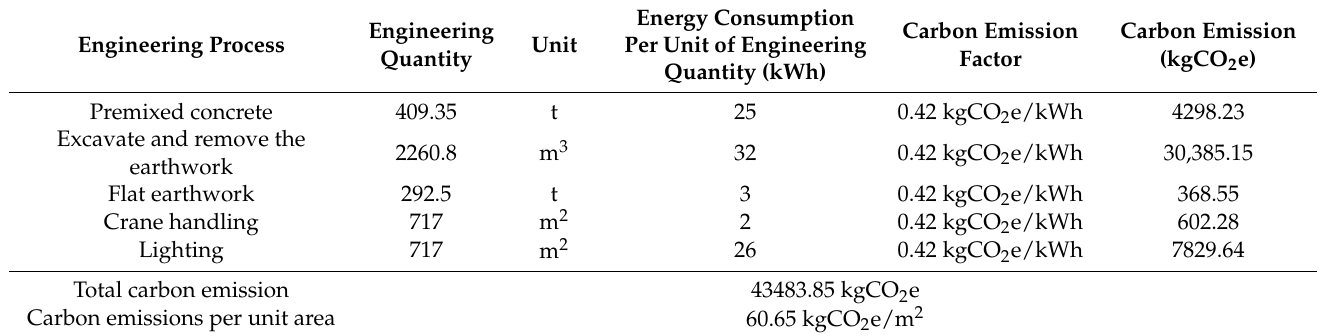
Table 4. Construction carbon emission of new